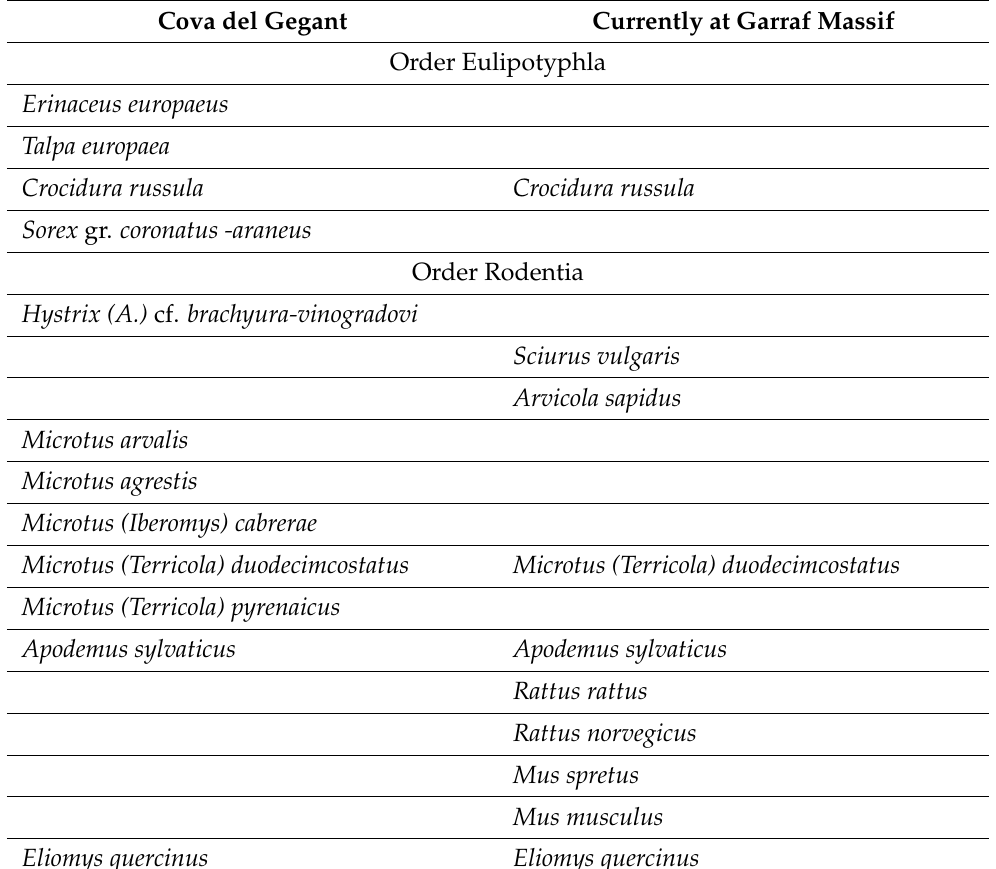
Table 6. Small mammal association of Cova del Gegant (left) in comparison with current small mammals that inhabit the Garraf Massif (right), according to Palomo et al.